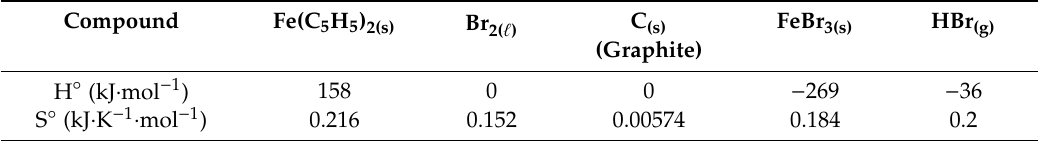
Table 1. Molar enthalpy (H ◦ ) and entropy (S ◦ ) values of the involved chemicals at standard conditions (1 atm, 298